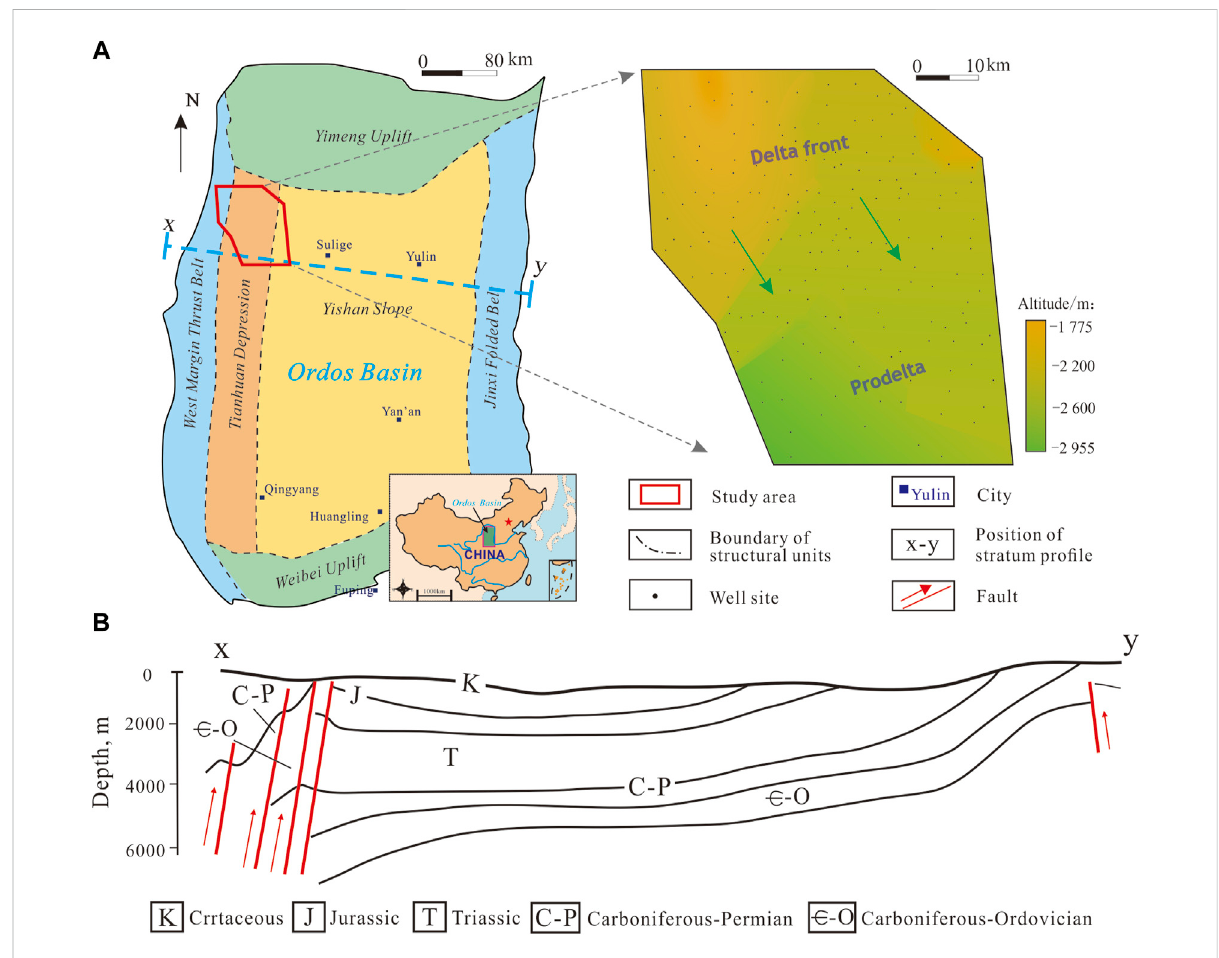
FIGURE 1 Geographical location of the study area and structural units of the Ordos Basin. (A) Location of the study area. The study area is an irregular polygon due to the topography limitations of the Western Margin Thrust Belt and the distribution of exploration wells. (B) Distribution of strata and faults through the line